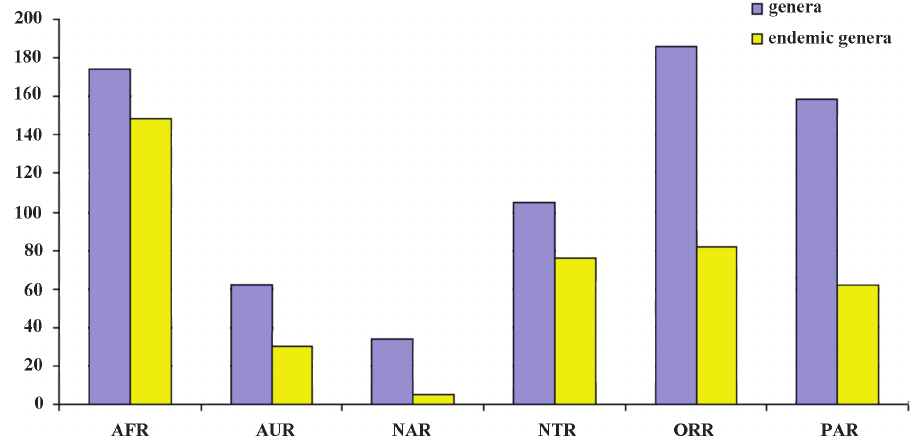
Figure 2. The numbers of genera and endemic genera in geographical